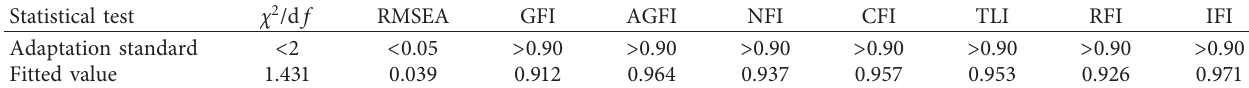
Table 2: Goodness-of-fit of the model.